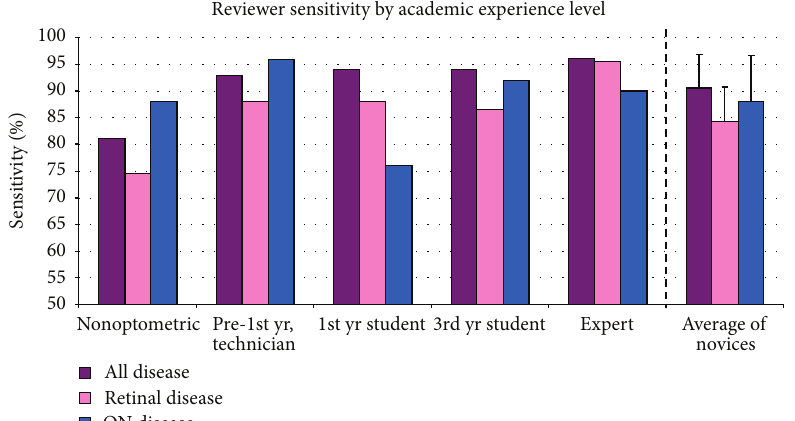
Figure 1: Sensitivity of reviewers for posterior segment disease identification, based on data provided with iWellnessExam™. Rightmost column set is an average of the performance of the four novices.